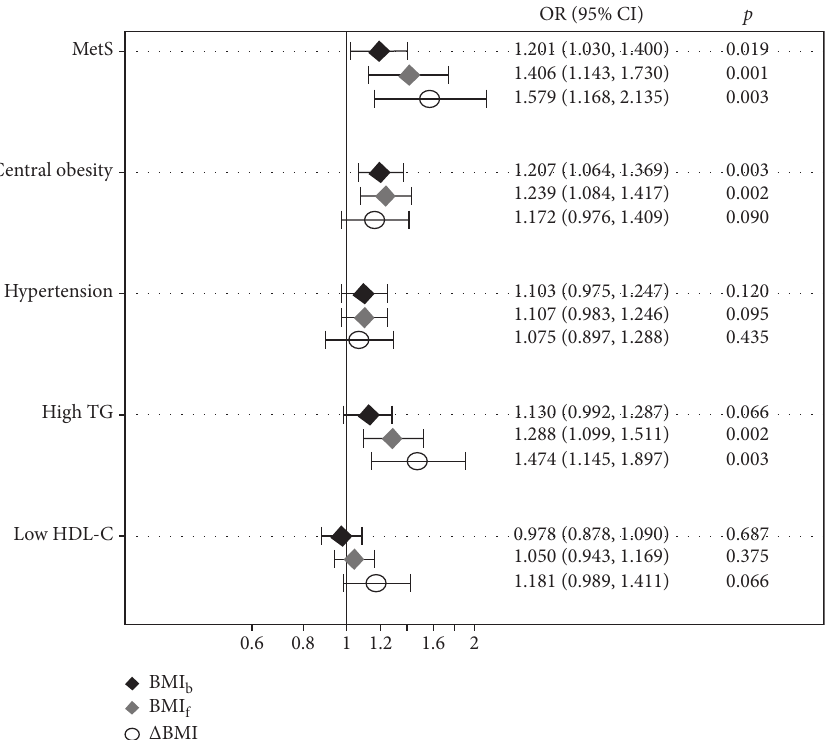
Figure 1: Association of baseline BMI (BMIb), follow-up BMI (BMIf), the change of BMI ( δ BMI) with the risk of metabolic syndrome (MetS) with central obesity, hypertension, high TG, and low HDL-C at follow up. OR � odds ratio. δ BMI � BMIf-BMIb.